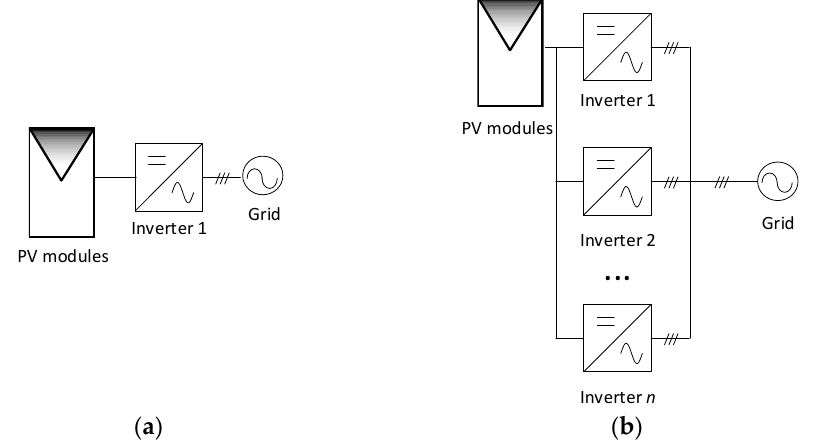
Figure 1. Topologies of high power central inverters. ( a ) Centralized inverter composed by a single power stage; ( b ) centralized inverter composed by n parallel modules